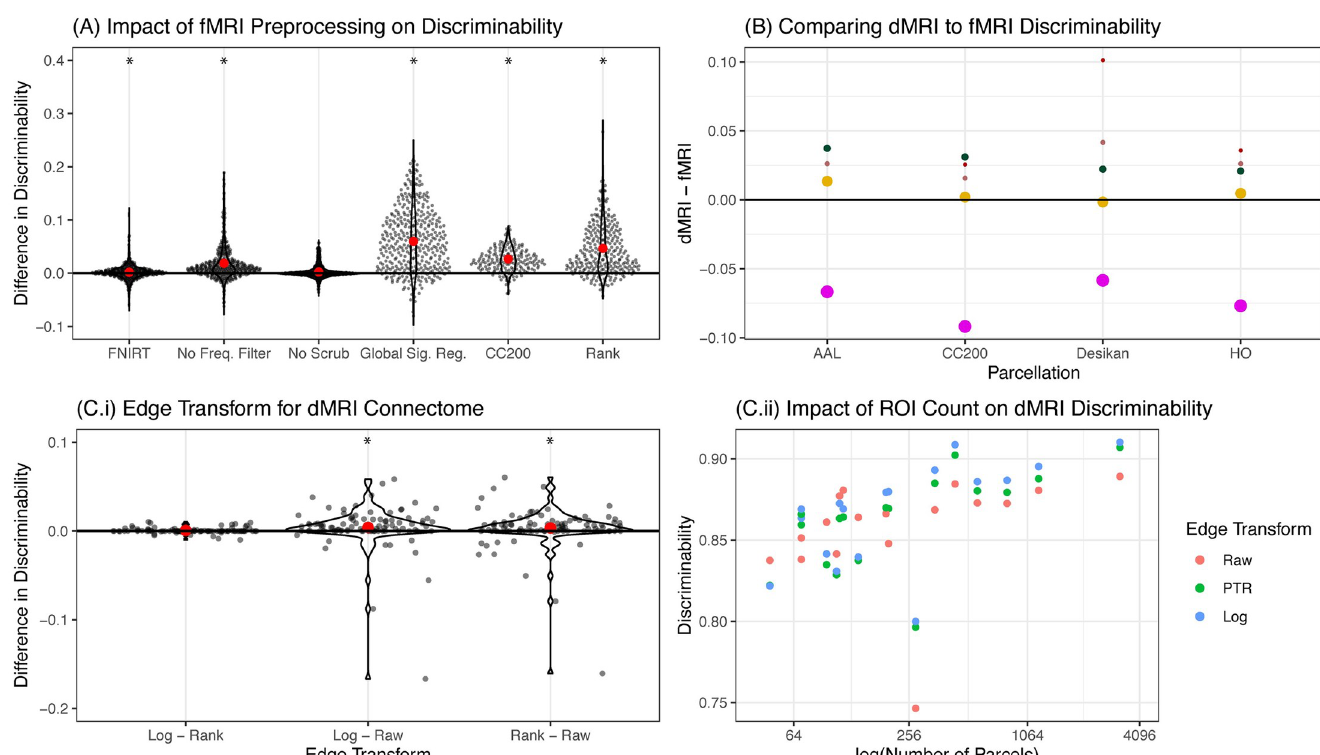
Fig 4. Parsing the relative impact on Discr of various acquisition and analytic choices. (A) The pipelines are aggregated for a particular analysis step, with pairwise comparisons with the remaining analysis options held fixed. The beeswarm plot shows the difference between the overall best performing option and the second best option for each stage (mean in red) with other options held equal; the x -axis label indicates the best performing strategy. The best strategies are FNIRT , no frequency filtering, no scrubbing, global signal regression, the CC200 parcellation, and ranks edge transformation. A Wilcoxon signed-rank test is used to determine whether the mean for the best strategy exceeds the second best strategy: a � indicates that the p -value is at most 0.001 after Bonferroni correction. Of the best options, only no scrubbing is not significantly better than alternative strategies. Note that the options that perform marginally the best are not significantly different than the best performing strategy overall, as shown in Fig 3. (B) A comparison of the stabilities for the 4 datasets with both fMRI and dMRI connectomes. dMRI connectomes tend to be more discriminable, in 14 of 20 total comparisons. Color and point size correspond to the study and number of scans, respectively (see Fig 3B). (C.i) Comparing raw edge weights (Raw), ranking (Rank), and log-transforming the edge-weights (Log) for the diffusion connectomes, the Log and Rank transformed edge- weights tend to show higher Discr than Raw. (C.ii) As the number of ROIs increases, the Discr tends to